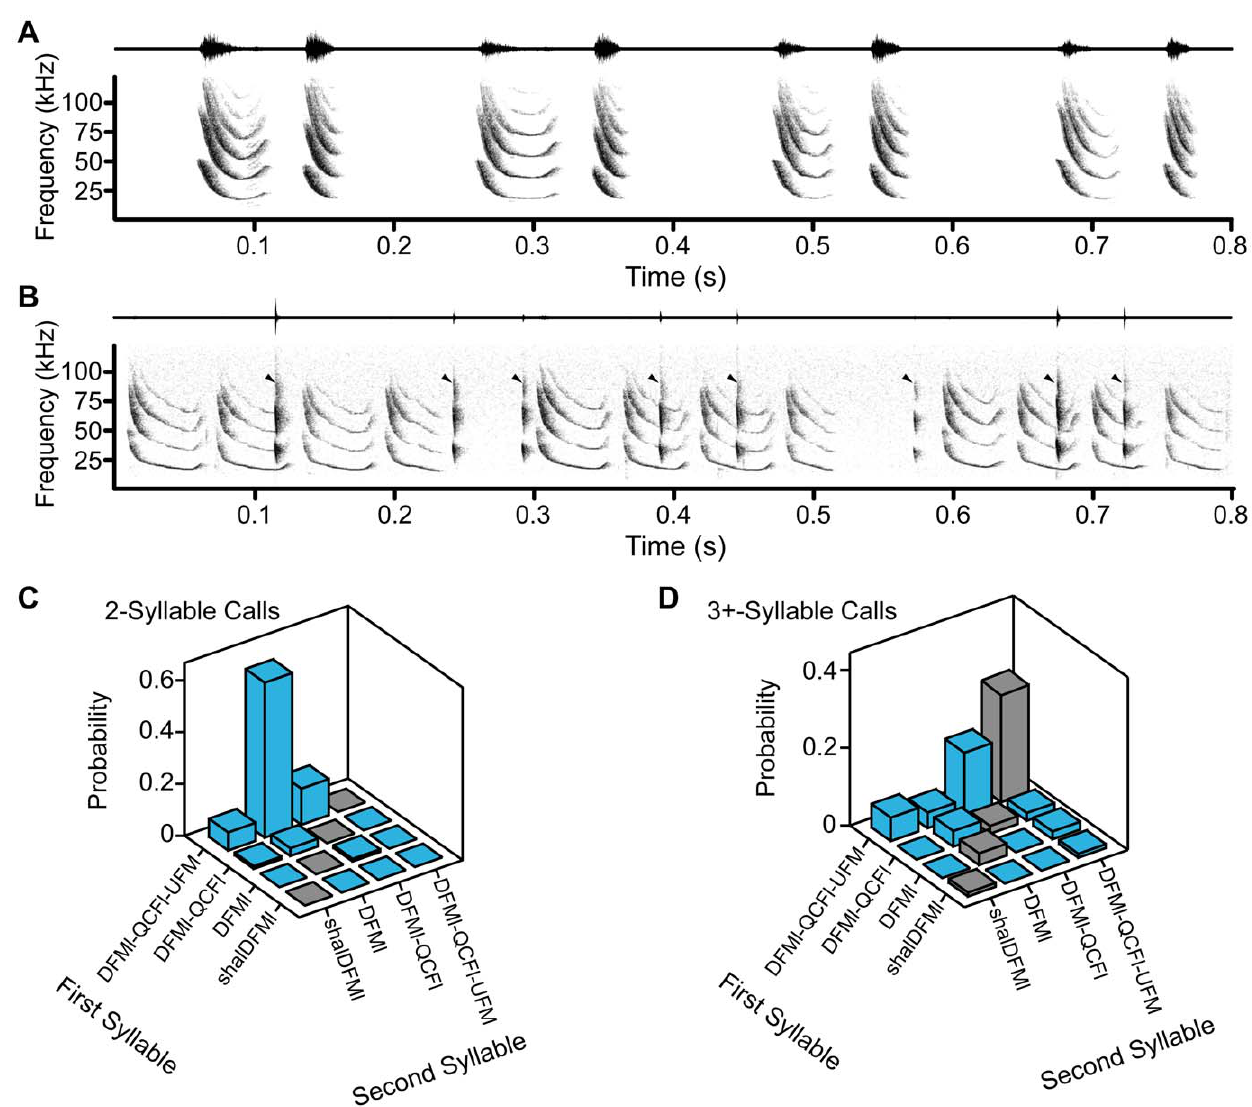
Figure 6. Two distinct appeasement call structures. Example waveforms ( upper trace ) and spectrograms ( lower trace ) showing two distinct call sequences. ( A ) A two-syllable call sequence that transitions from DFMl-QCFl-UFM to DFMl. ( B ). A three or more syllable call sequence that repeats DFMl-QCFl-UFM three times and then transitions to DFMl-QCFl at the end of the call. This calls sequence also shows overlapping biosonar calls ( arrowhead ) emitted by another bat. Peak amplitude of the entire bout was normalized. Due to the large difference in amplitude between the biosonar and appeasement syllables, most appeasement syllables are not visible in the waveform trace shown in B. Examining the probability of two- syllable pairings reveals distinct syllable ordering rules for appeasement calls that contain only two syllables ( C ) or those with at least three syllables ( D ). Blue bars represent syllable transitions and grey bars represent repeated syllable pairings.